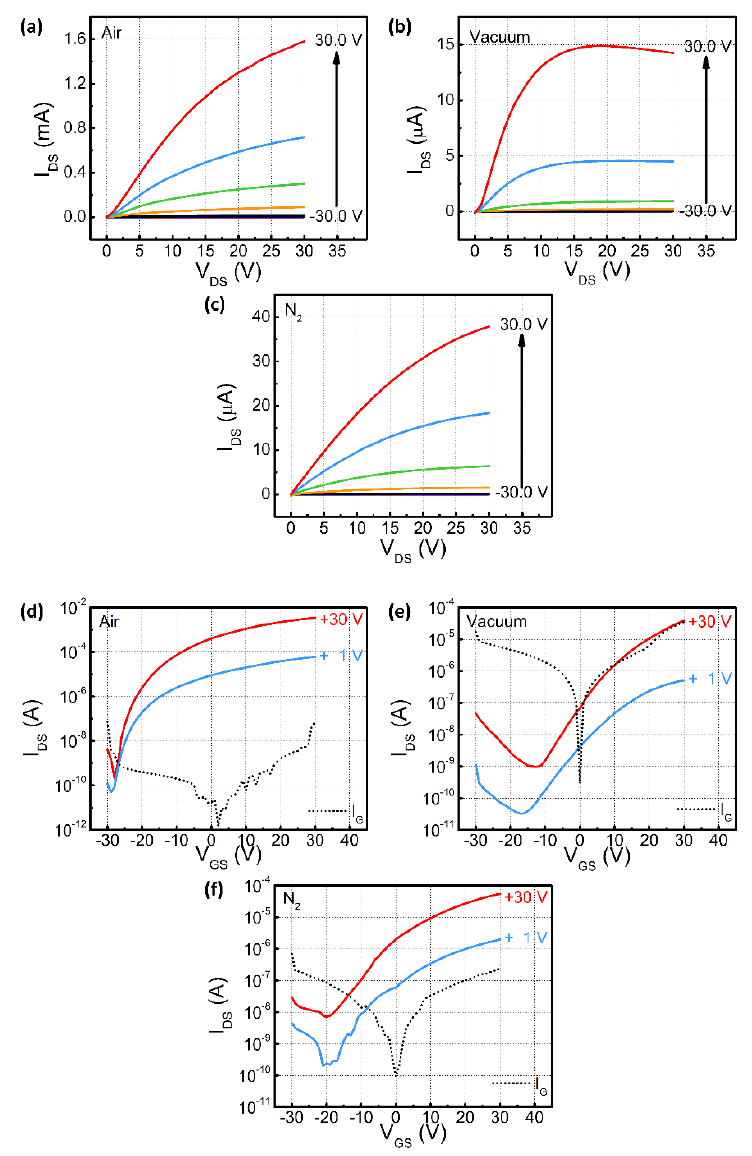
Figure 3. I D -V D curves obtained for TFTs consisting of SnO 2 films annealed in ( a ) air, ( b ) vacuum, and ( c ) N 2 . The corresponding transfer curves of SnO 2 TFT annealed in ( d ) air, ( e ) vacuum, and ( f ) N 2 with different V DS .